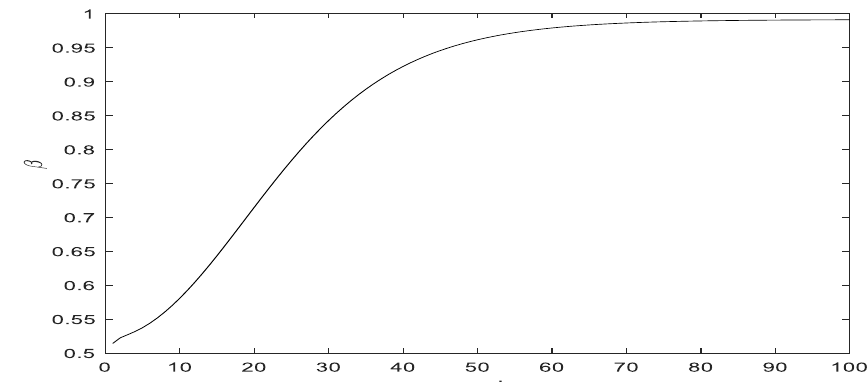
Fig. 10. A scenario showing the adaptation of the user defined parameter, β , of